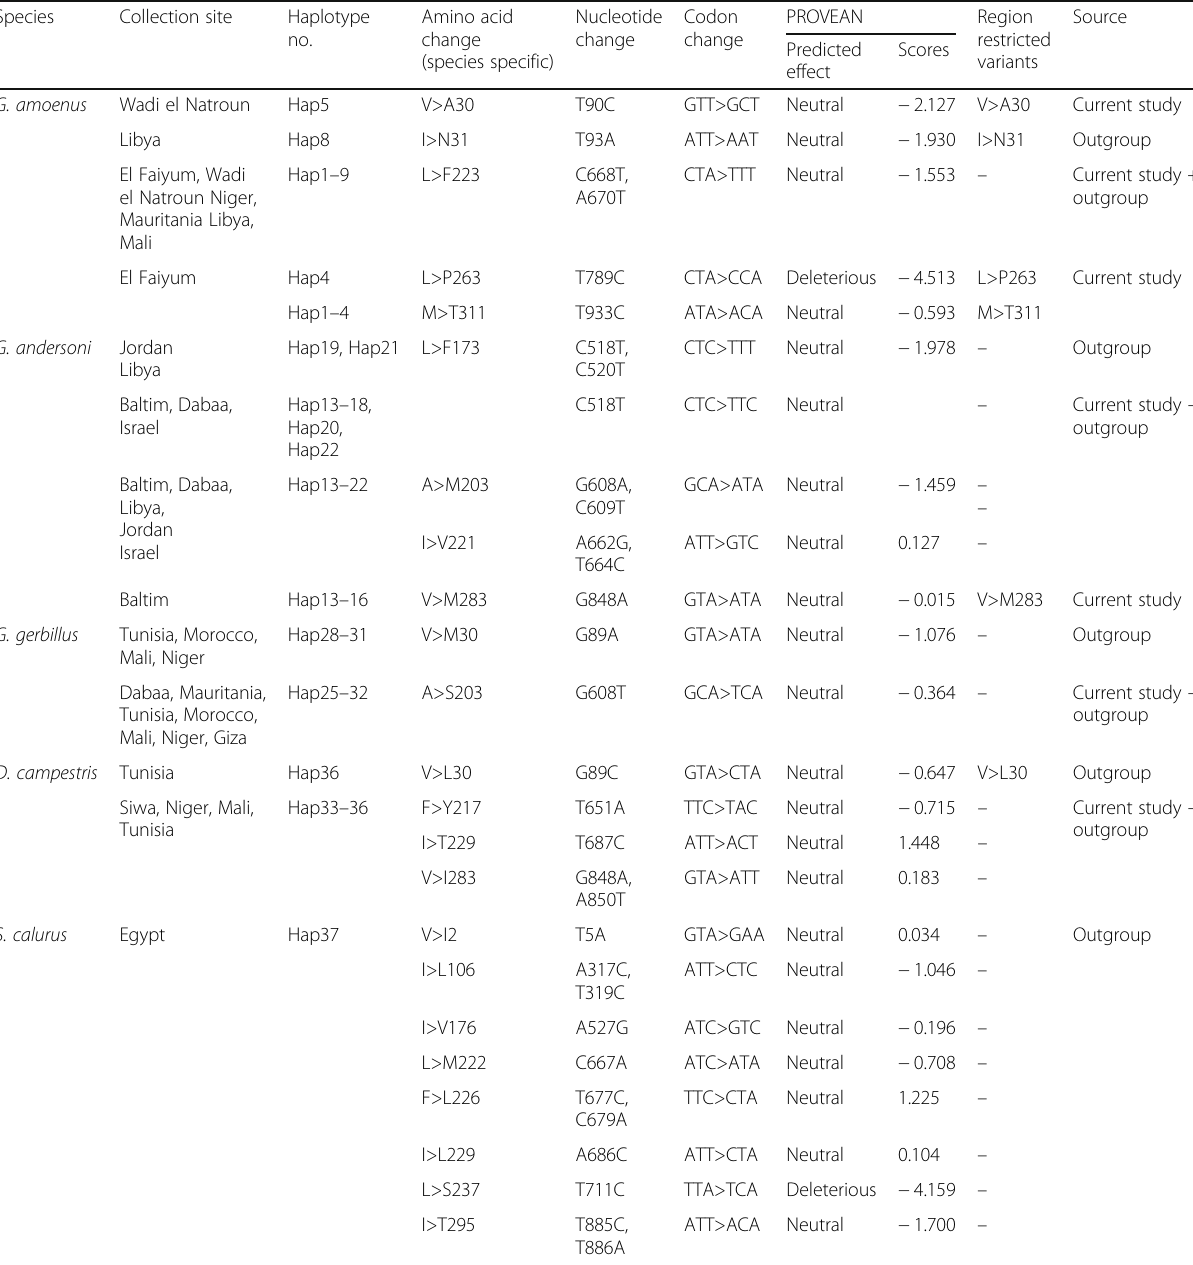
Table 2 Intraspecific variation within different species of the Gerbillus species Species Collection